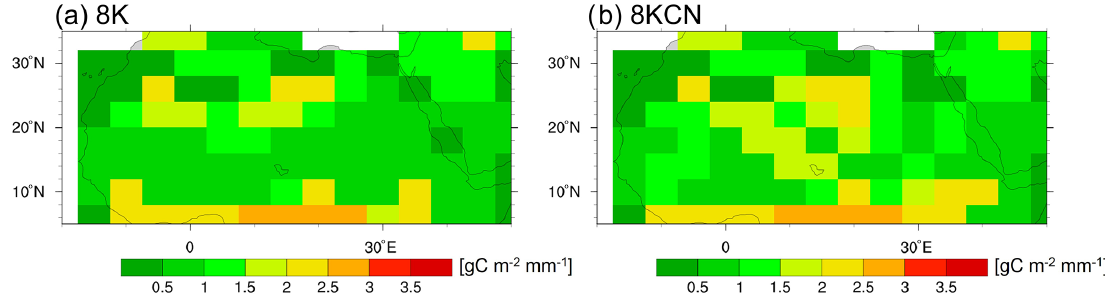
Figure 5. WUE (water use efficiency, gCm − 2 mm − 1 ) during the growing season in the 8K (a) and 8KCN (b)